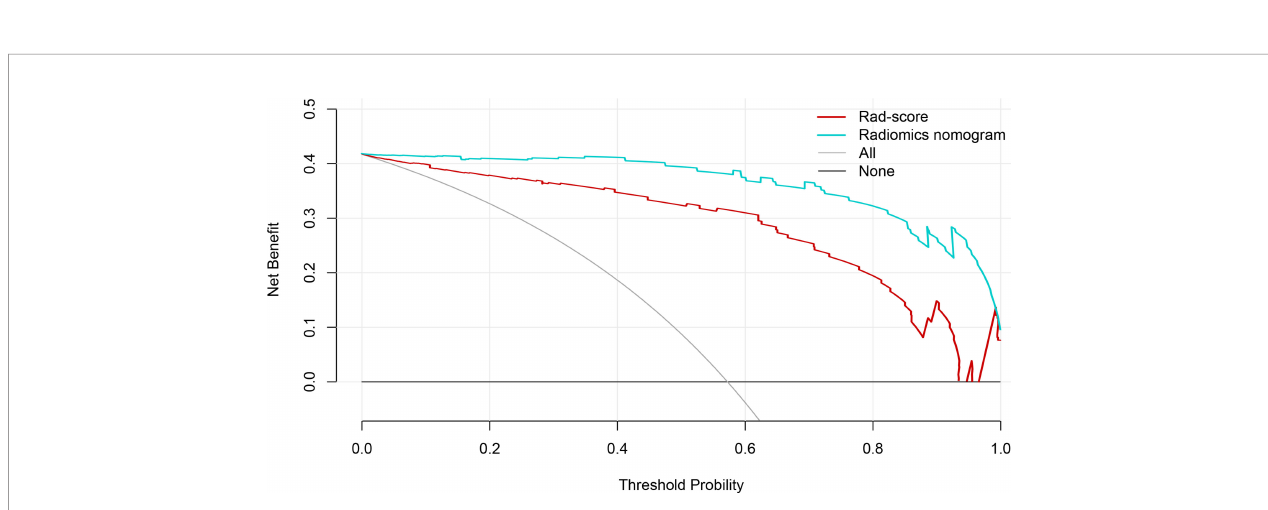
FIGURE 8 | The decision curves of the Rad-score, radiomics nomogram, and two extreme curves were plotted based on the validation dataset. It showed that the use of the radiomics nomogram to predict CIP probability in patients with non-small cell lung cancer has a greater bene fi t than the use of